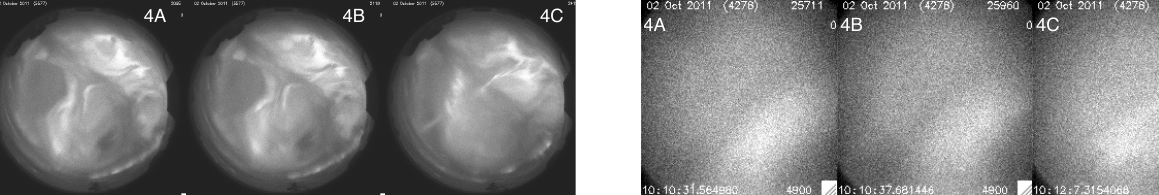
Figure 14. Event 4: all-sky images – taken on 2 October 2011 with a 557.7nm filter – showing the dynamic overall structure of the aurora at the times of the NEIALs in the PFISR data (labeled 4A–4C). North is down and east is to the right.